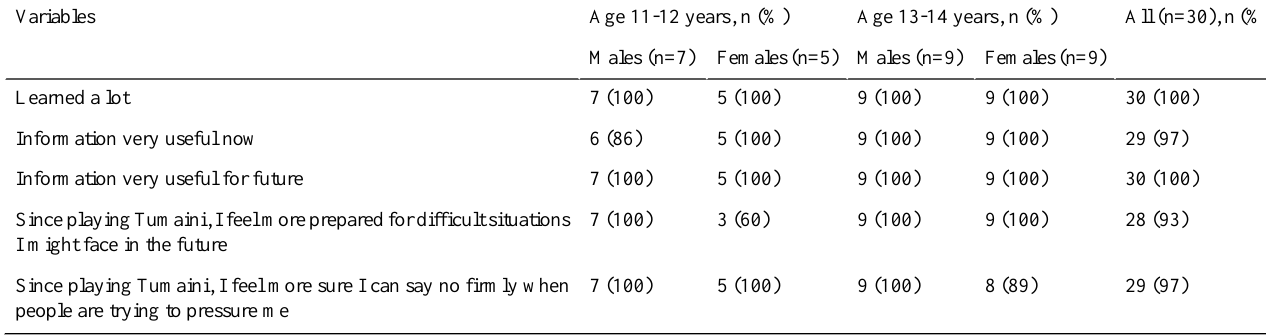
Table 4. Frequency and percentage of participants responding most positively to questions on value of game by